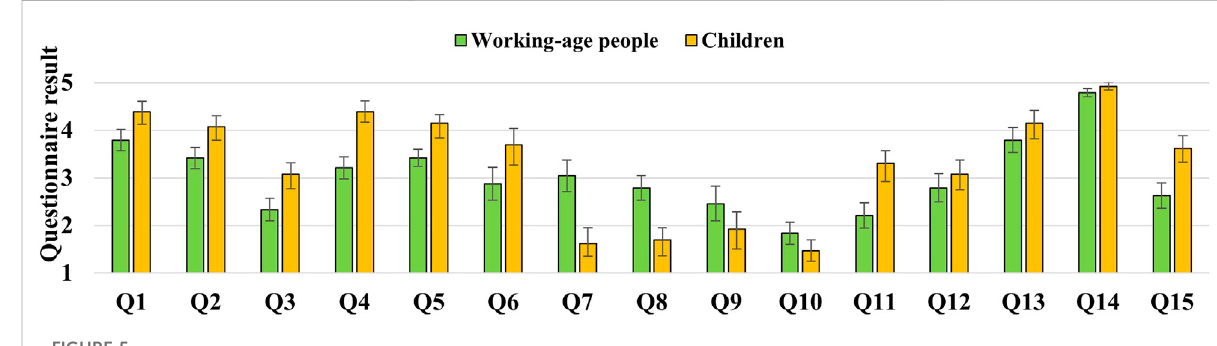
FIGURE 5 Results of the questionnaires in the experiment with working-age people and children.